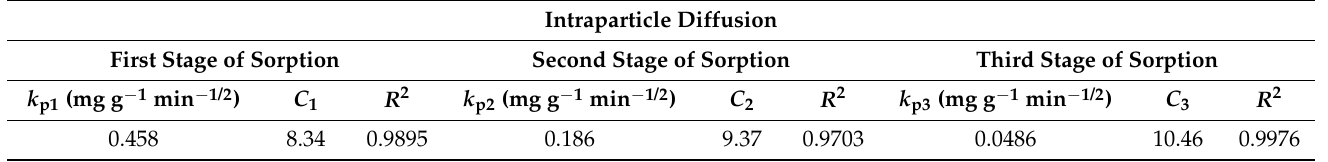
Table 2. Intraparticle diffusion model constants and correlation coefficients for the adsorption of CIP on the ternary Fe 3 O 4 /SiO 2 /TiO 2